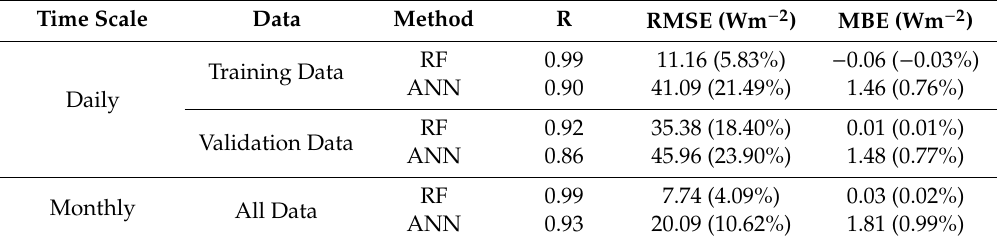
Figure 14. Results of evaluation for monthly mean estimated R S data from Himawari-8 AHI data using the ANN method with ground-measured R S from CDC / CMA from February to May 2016. N is the number of data point. Table 3. Statistical parameters of training and validation data of two models at the daily and monthly time scale.